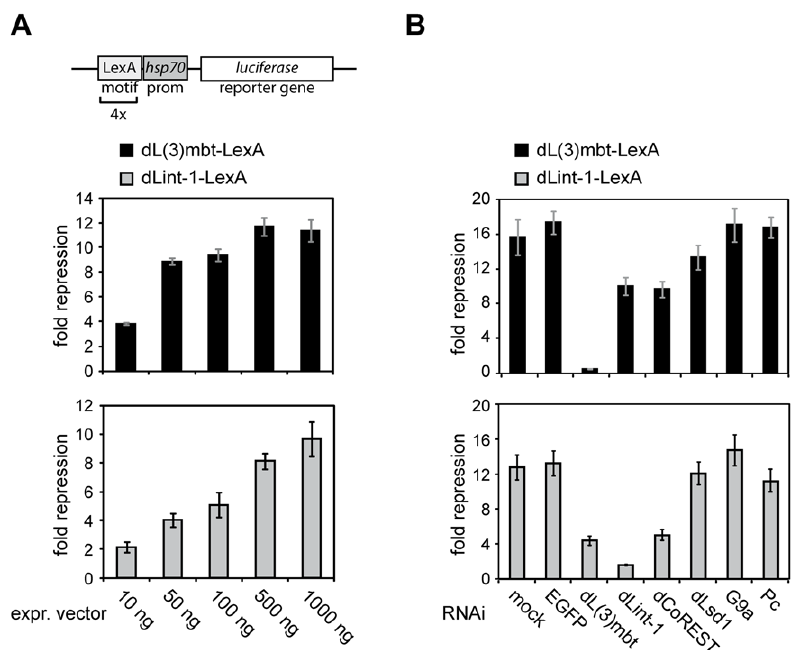
Figure 7. Promoter recruitment of LINT subunits results in transcriptional repression. (A) A Firefly luciferase reporter construct (schematic representation on top) was transiently cotransfected into RNAi treated Kc cells along with a Renilla luciferase reporter and varying amounts of expression vectors for LexA or dL(3)mbt-/dLint-1-LexA fusion proteins as indicated. Repressor activities of dL(3)mbt-LexA and dLint-1-LexA are presented as -fold repression normalized against activities measured for LexA expression alone. (B) Kc cells were treated with no dsRNA (mock) or